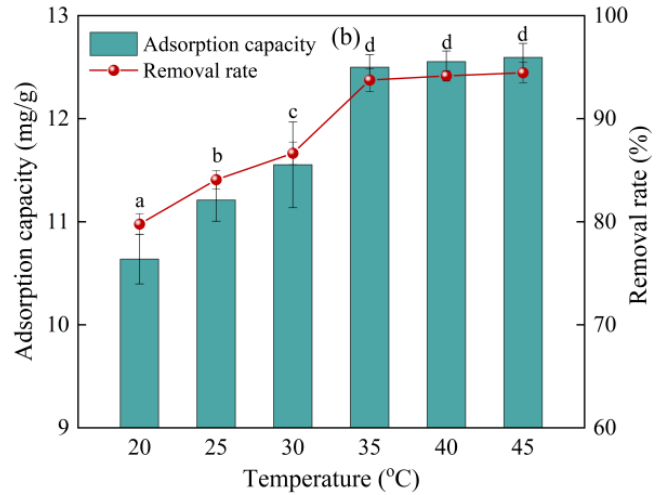
Figure 4. Effects of initial diuron concentration and solution temperature on the adsorption of diuron by SDMBC600: ( a ) initial diuron concentration; ( b ) solution temperature. (0.075 g SDMBC600, t = 360 min). Different letters indicate significant differences between different treatments at the 0.05 level, testing by one-way ANOVA.